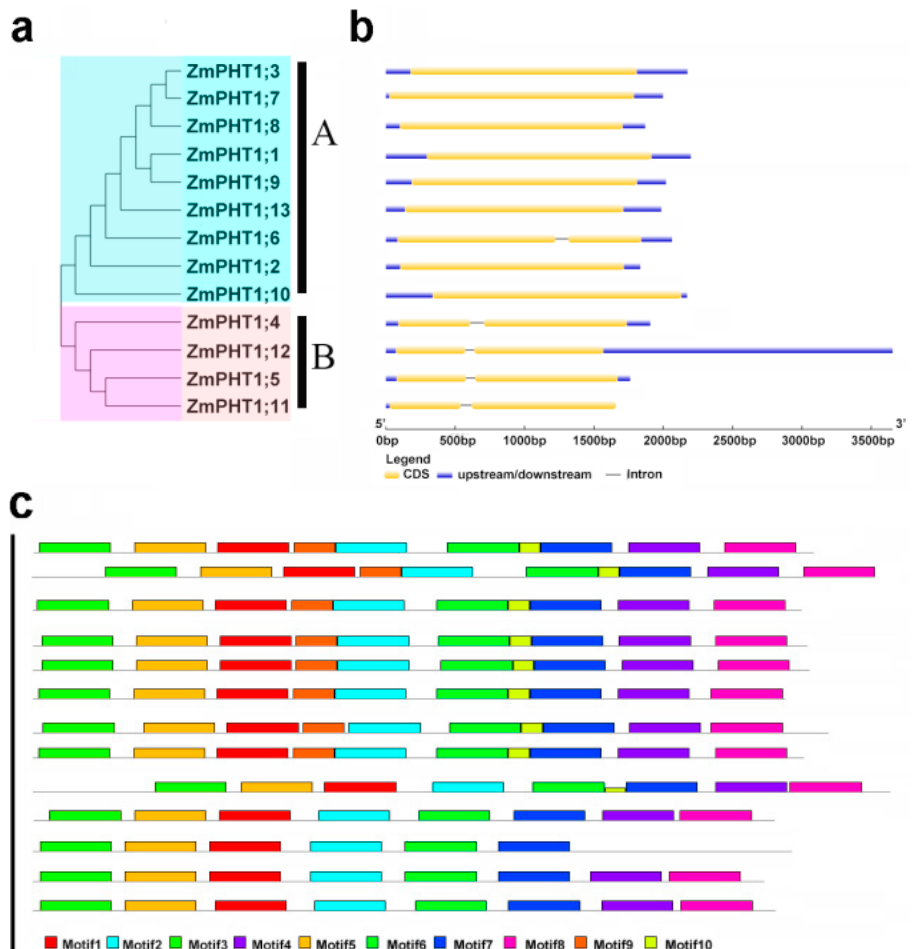
Figure 2. Phylogenetic tree, motif and gene structure of ZmPHT1 genes. ( a ) The phylogenetic tree contains only ZmPHT1s, which were divided into two groups (Class A and Class B); ( b ) exons are indicated by grey boxes, and introns are indicated by single lines; black lines represent untranslated regions (UTR); ( c ) motifs’ analysis; different colors represent different motifs.